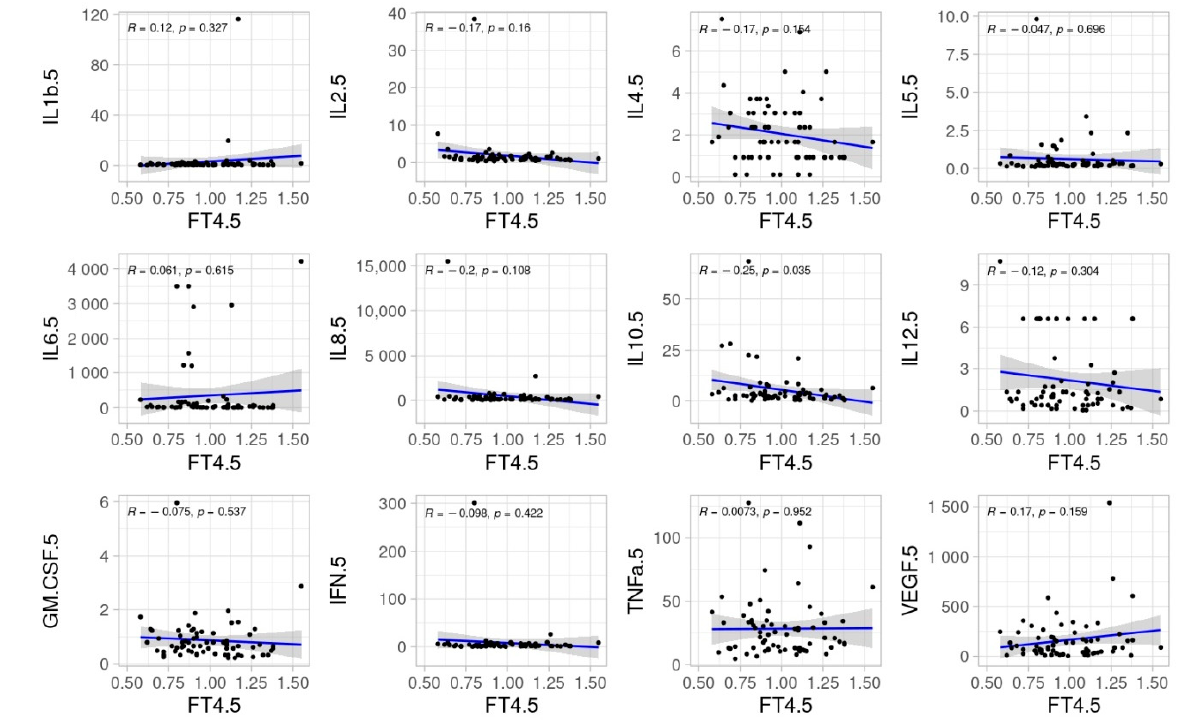
Figure 3. Scatter dots of correlations between fT3 and cytokines at day 5 .